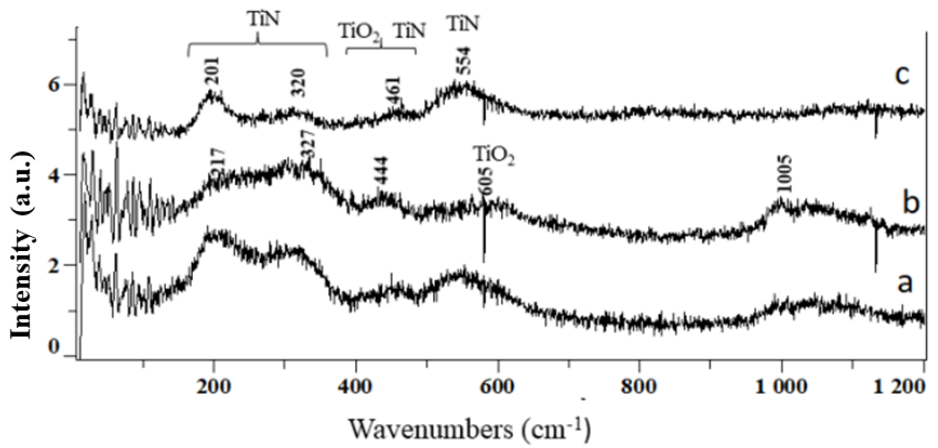
Figure 5. Raman scattering spectra of Mo–Ti bilayer films heated at 600 °C and exposed to (Ar-31%N 2 - 6%H 2 ) plasma for 1 h 30 min ( a ) and 3 h ( b ), heated at 800 °C and exposed to (Ar-31%N 2 -6%H 2 ) plasma for 3 h ( c ).